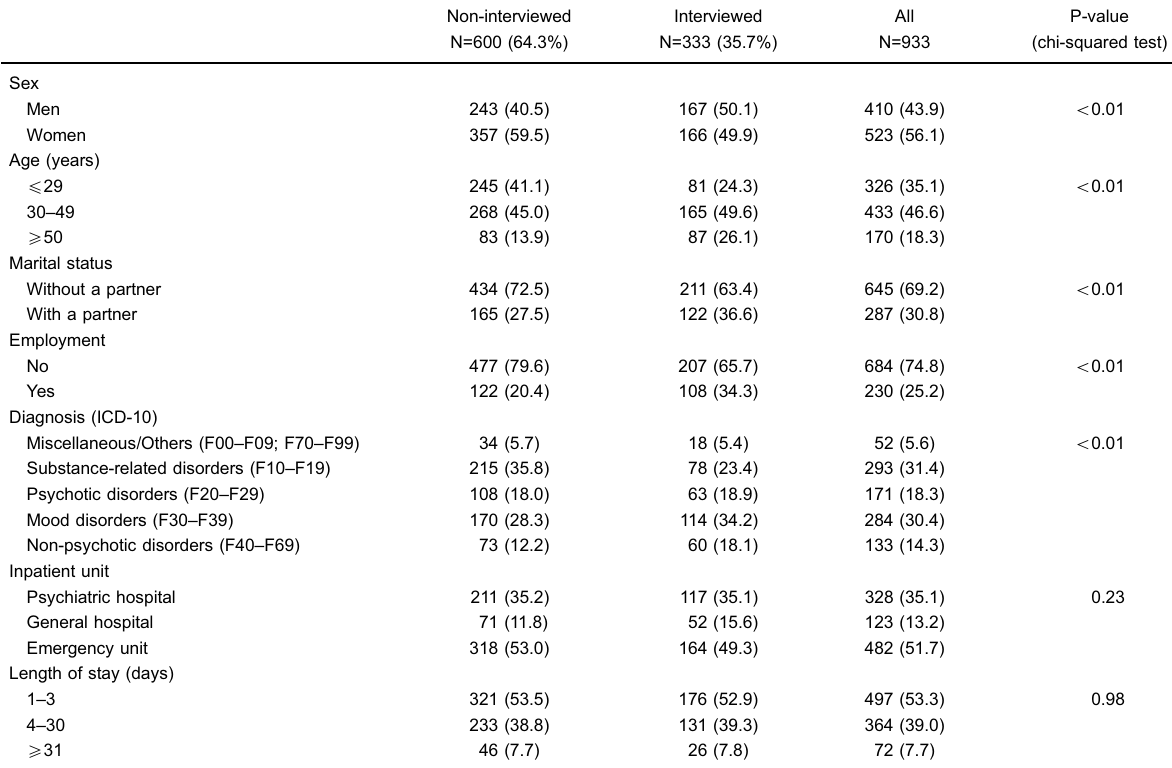
Table 1. Associations between the sociodemographic characteristics of the interviewed and non-interviewed